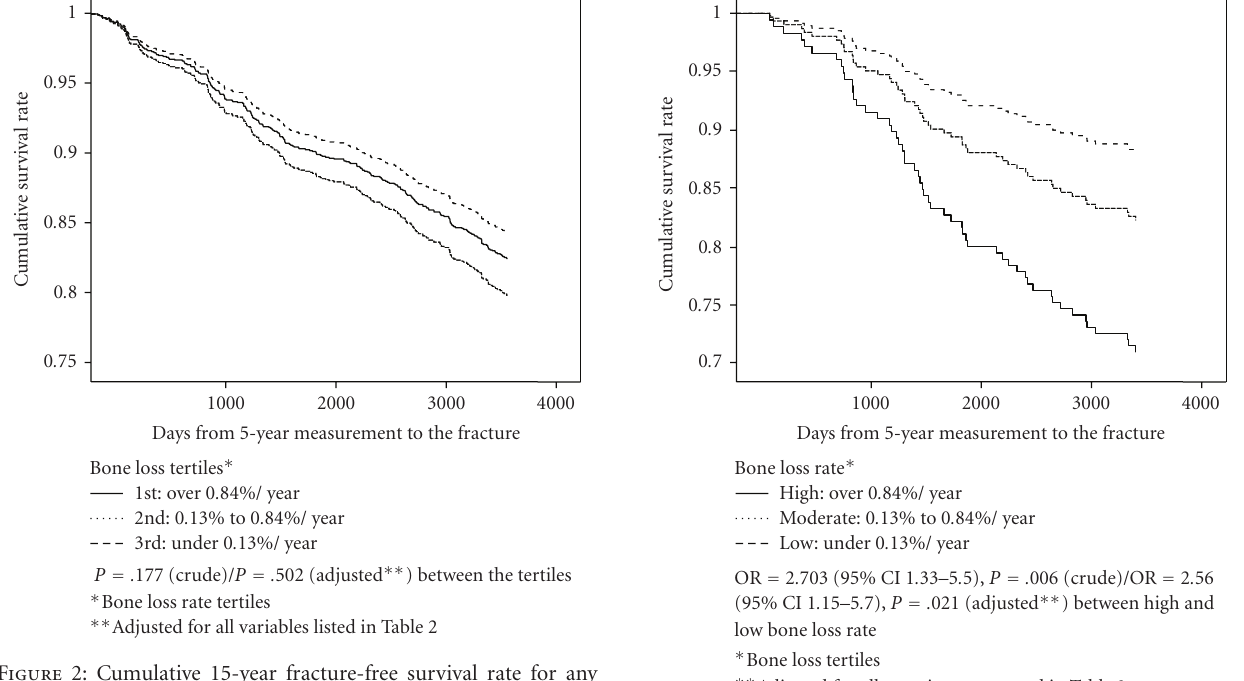
Figure 2: Cumulative 15-year fracture-free survival rate for any fragility fracture according to annual bone loss rate (tertiles) ∗ . Cox proportional hazard model ( n = 1652). Figure 3: E ff ect of bone loss rate on fracture risk among women